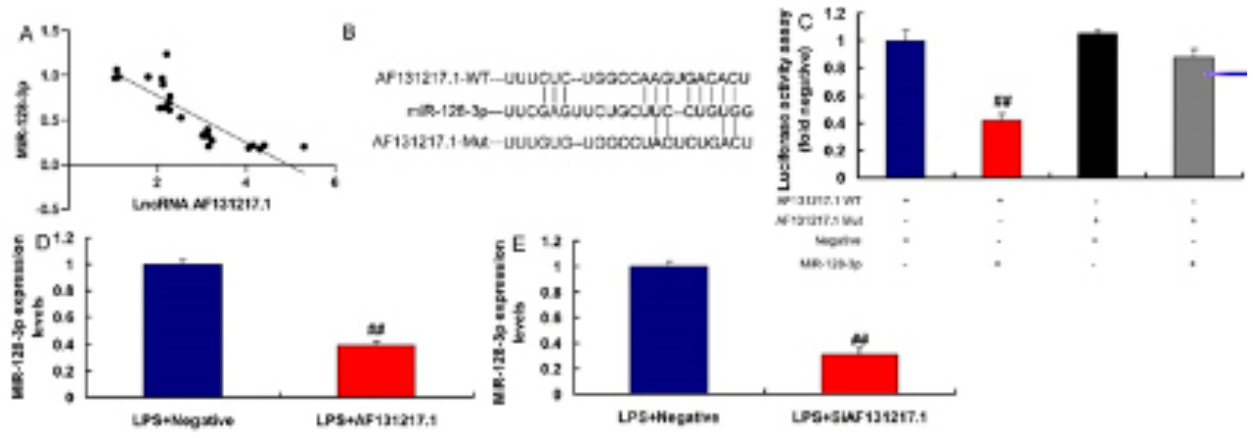
Fig. 3 - Micro ribonucleic acid (miR)-128-3p is a target spot of long noncoding ribonucleic acid (lncRNA) AF131217.1 on the inflammation in vitro model. MiR-128-3p expression had a negative correlation with lncRNA AF131217.1 levels in the coronary slow flow model (A). The luciferase reporter plasmid containing wild type (WT) or mutant (Mut) AF131217.1 was cotransfected with miR-128-3p (B and C), overexpression of lncRNA AF131217.1 suppressed miR-128-3p expression (D), downregulation of lncRNA AF131217.1 induced miR-128-3p expression in lipopolysaccharide (LPS)-induced in vitro model (E). LPS+Negative, LPS-induced in vitro model by negative mimics group; LPS+AF131217, LPS- induced in vitro model by AF131217.1 group. ## P<0.01 compared with LPS+Negative group.